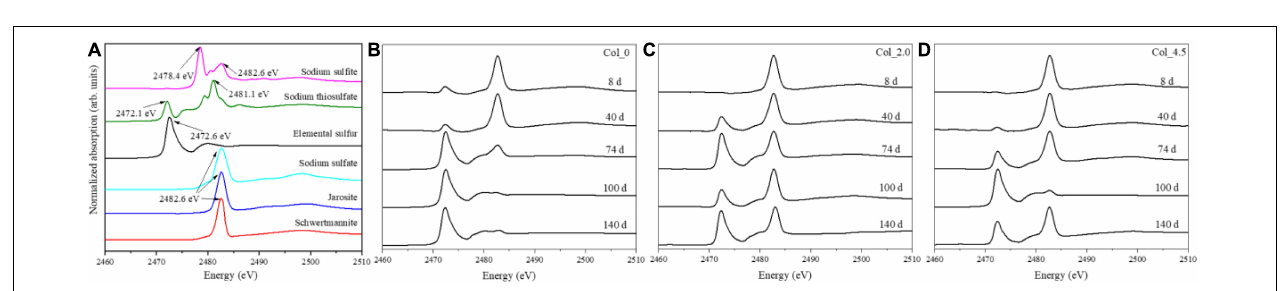
FIGURE 4 | Normalized Fe L-edge XANES spectra for the bottom residues during cultivation without (A) and with additions of 2.0 mM (B) and 4.5 mM (C) As(III), where the green and blue bands represent Fe(II) and Fe(III) species, respectively.